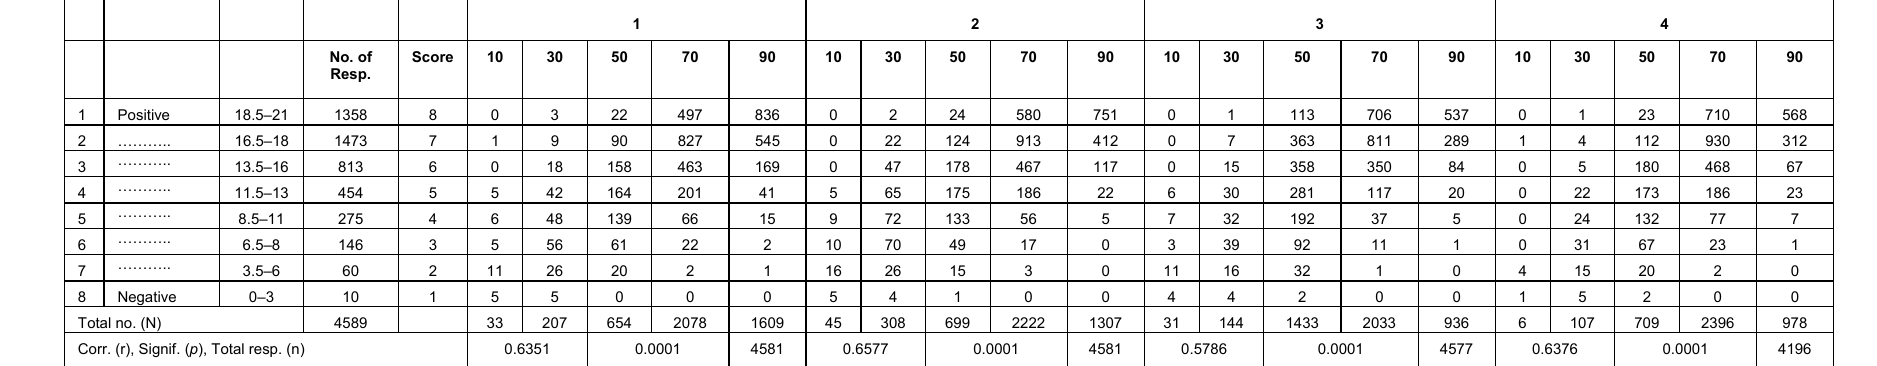
When the View of Life (Positive vs. Negative) is Plotted vs. the Global Quality of Life, the Nonlinear Nature of the Covariation becomes Apparent (see text) (Note the Distorted Distribution Away from the Low Quality of Life)